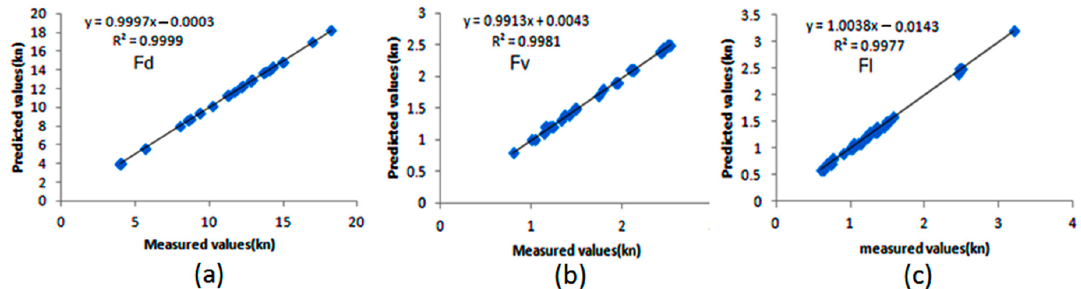
Figure 10. The relationship between the values measured and predicted by the ANFIS models for ( a ) draft force (Fd), ( b ) vertical force (Fv), and ( c ) lateral force (Fl); y indicates the regression relationship between the measured values and the predicted values.